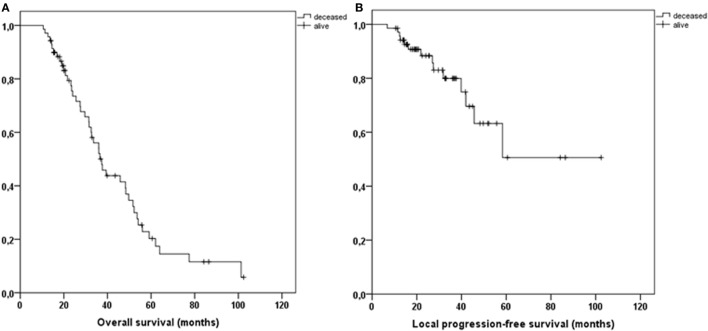
Kaplan–Meier curves illustrating overall survival (A) and local progression-free survival (B) for all patients.